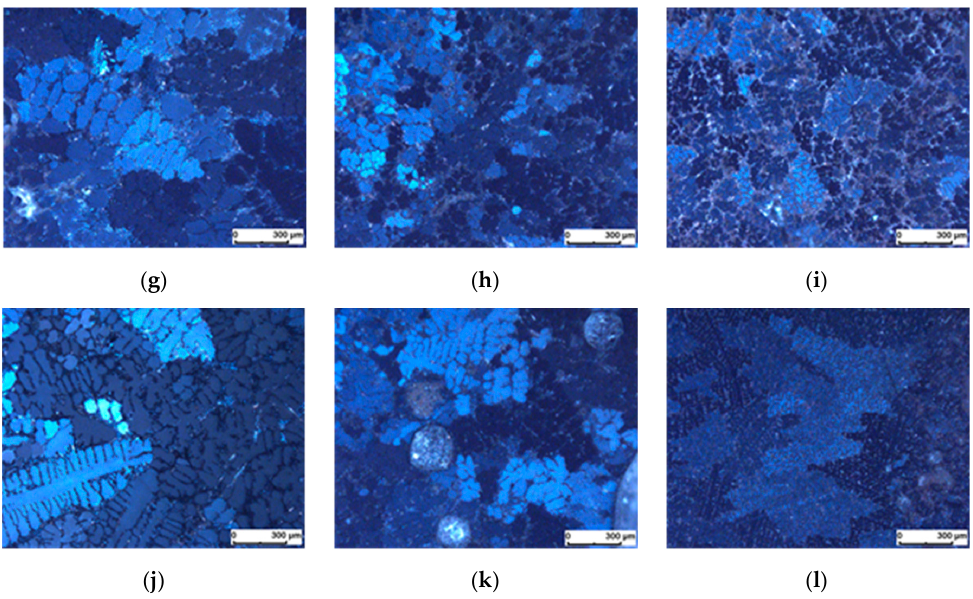
Figure 3. Metallographic sections of powder compacts containing ( a – c ) no additives (AlSi7 reference material), ( d – f ) Sr, ( g – i ) TiB 2 and ( j – l ) B additions after thermal treatment (melting) for 5 min at 660 °C and cooling via ( a , d , g , j ) natural convection (NC), ( b , e , h , k ) forced convection (FC) and ( c , f , i , l ) water quenching (WQ), revealing differences in grain size and morphology (Barker etching). Content levels of Sr, TiB 2 and B are 250, 350 and 140 ppm, respectively.